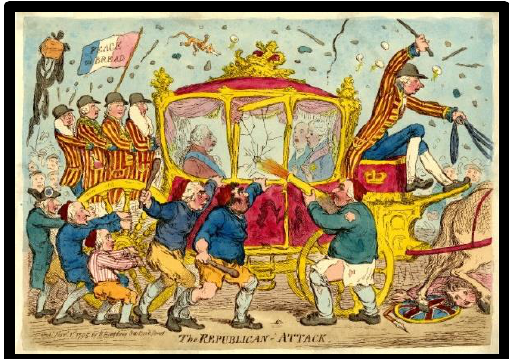
Figure 1 : Gillray, J. (1795, 1 November). The Republician Attack . (URL 1)